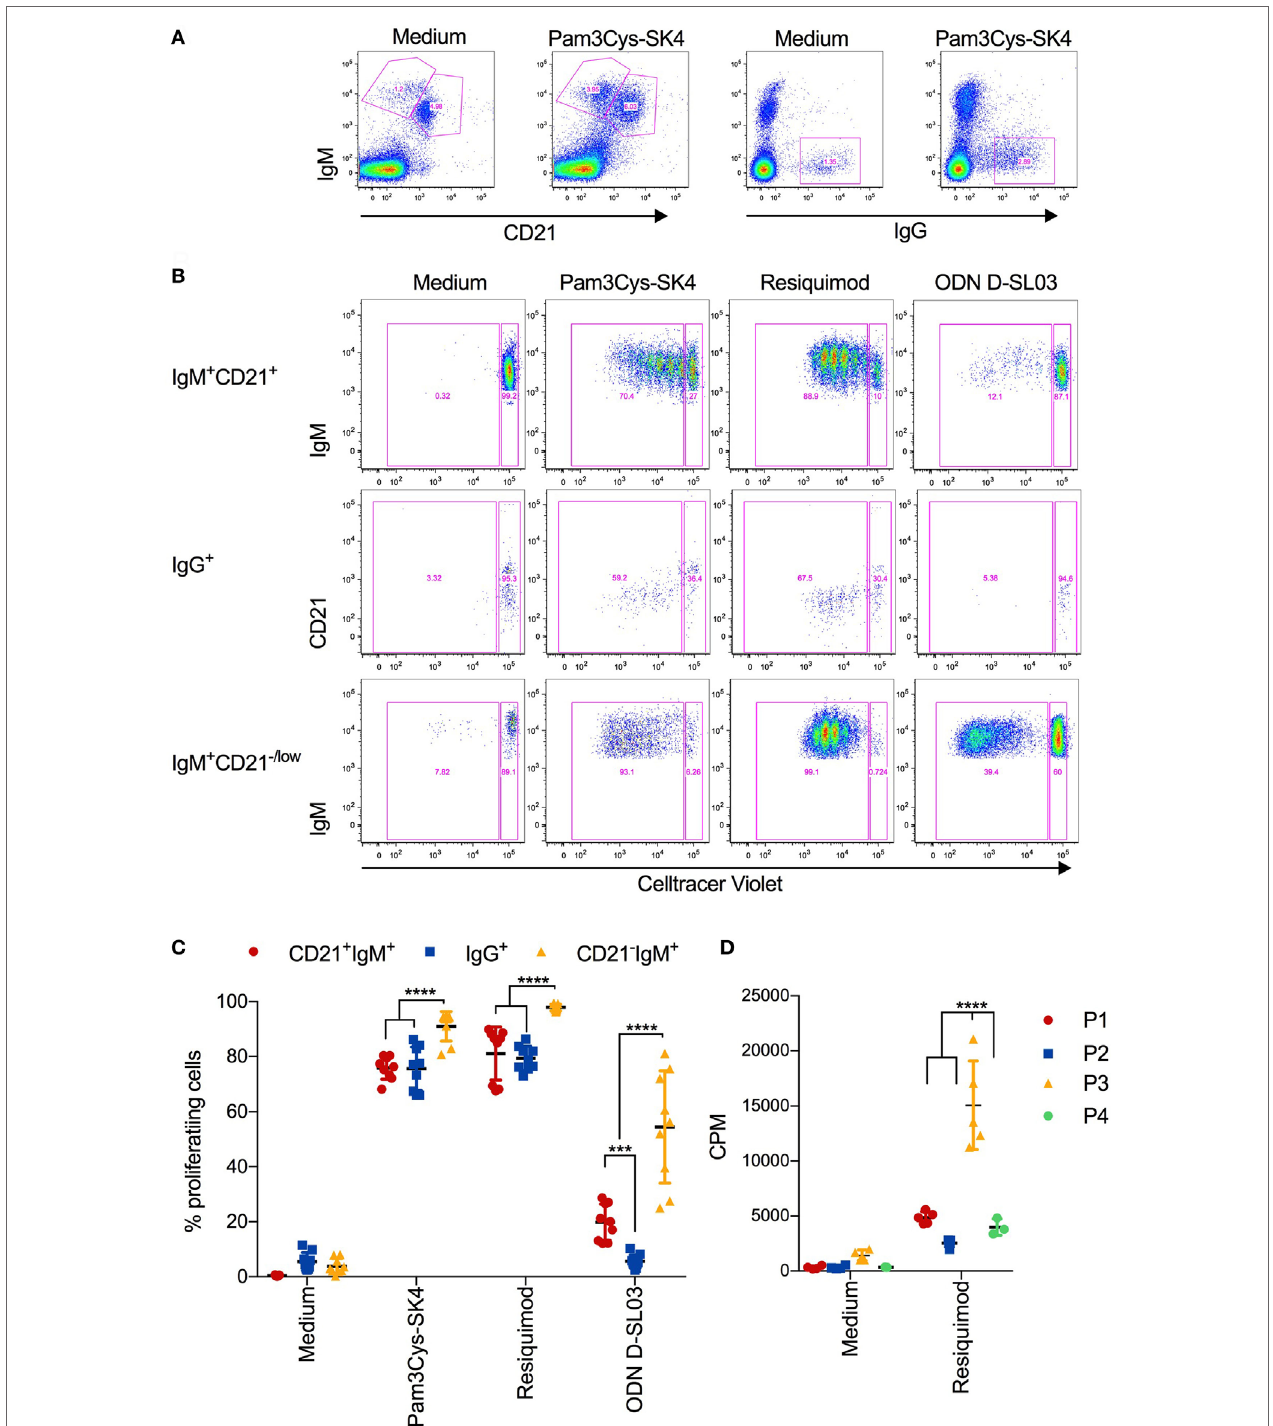
FigUre 4 | Proliferative responses of B cell subsets after stimulation with toll-like receptor (TLR) ligands (a) Gating strategy defining CD21 + IgM + , CD21 + IgM + , and IgG + B cells, exemplified for unstimulated and Pam3Cys-SK4 stimulated peripheral blood mononuclear cells (PBMCs) after 5 days of culture. (B) CellTrace Violet staining of the three B-cell subsets defined in (a) using multicolor flow cytometry. PBMCs were cultured for 5d. A representative animal out of three is shown. (c) Percentage of proliferating B cell subsets, defined as shown in (a,B) , after stimulation of PBMCs with the indicated TLR ligands. Triplicates cultures from three different animals are shown. (D) Proliferation of FACS-sorted B cell subsets after stimulation for 3 days was determined using 3 H-thymidine incorporation. P1 was defined and sorted as CD21 + IgM + subset, P2 as IgG + subset, P3 as CD21 − IgM + CD11R1 + subset, and P4 as CD21 − IgM + CD11R1 − subset (for gate definition see Figure 2 ). (c,D) Mean values are indicated by horizontal bars. Error bars show SDs. Statistical significance was calculated using ANOVA followed by Tukey’s